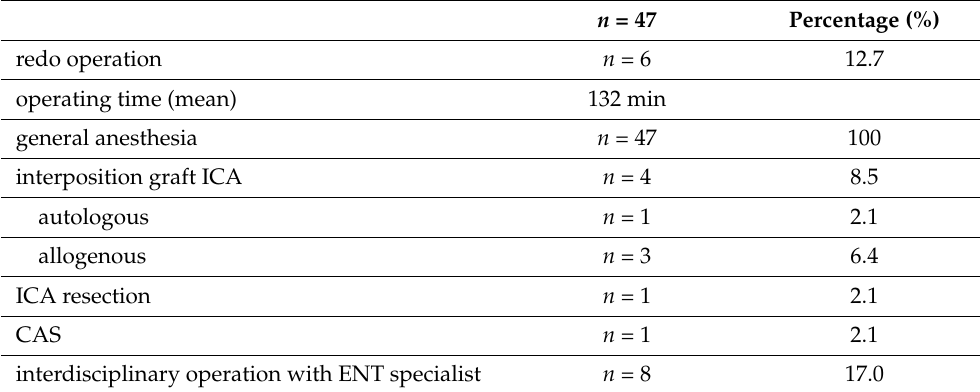
Table 2. Operative characteristics. ICA: internal carotid artery; CAS: carotid artery stenting; ENT: ear, nose, and throat